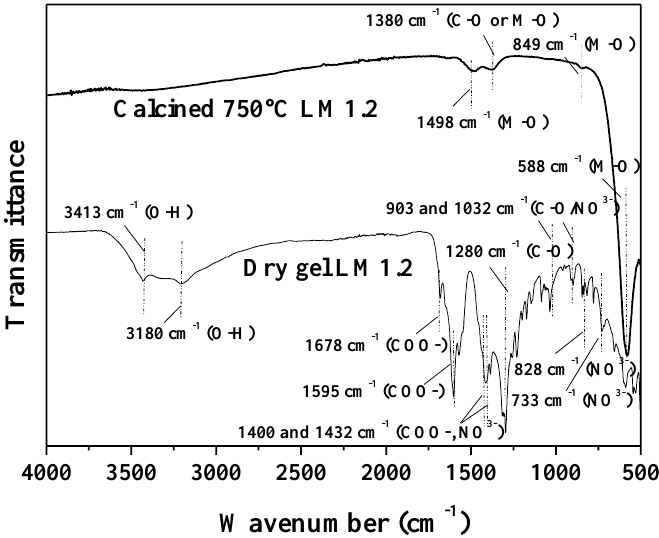
Figure 4. Fourier Transform Infrared Spectroscopy (FT-IR) spectra of the dried gel (non-calcined precursor materials) and calcined powder for LM1.2.